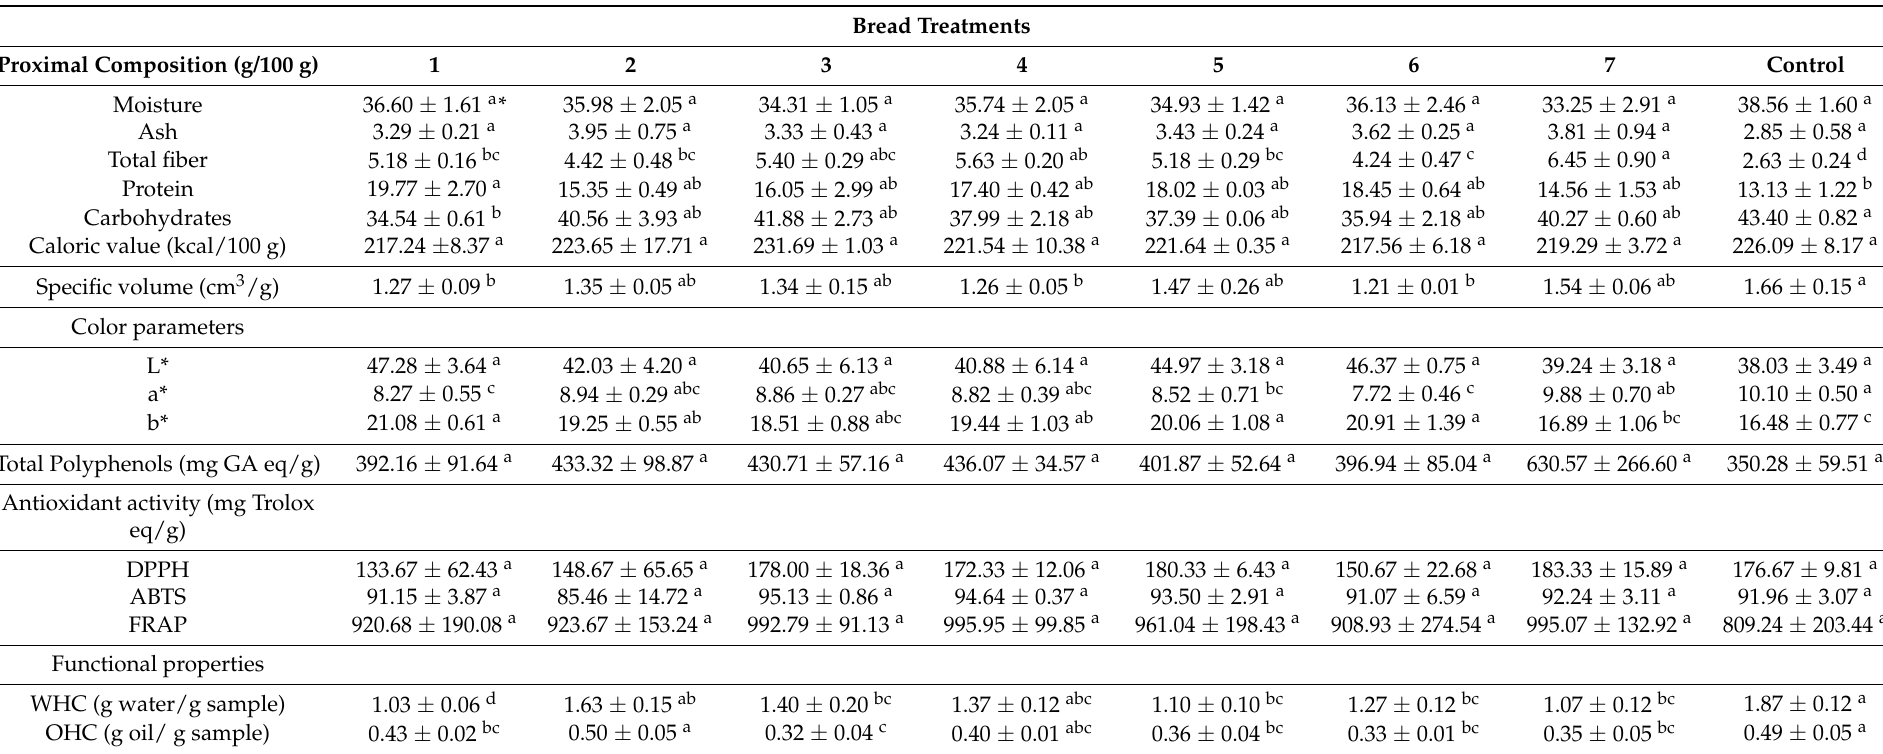
Table 4. Proximal composition, antioxidant, and functional activities of sourdough loaves of bread. Bread